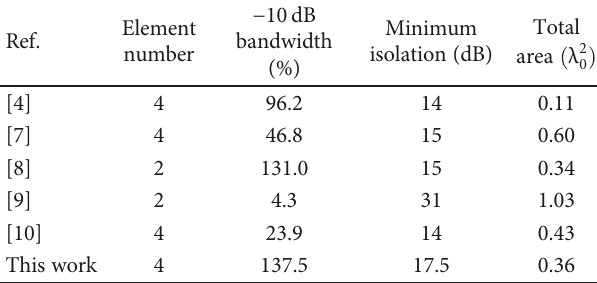
Table 1: Comparison with other MIMO antennas. Ref.